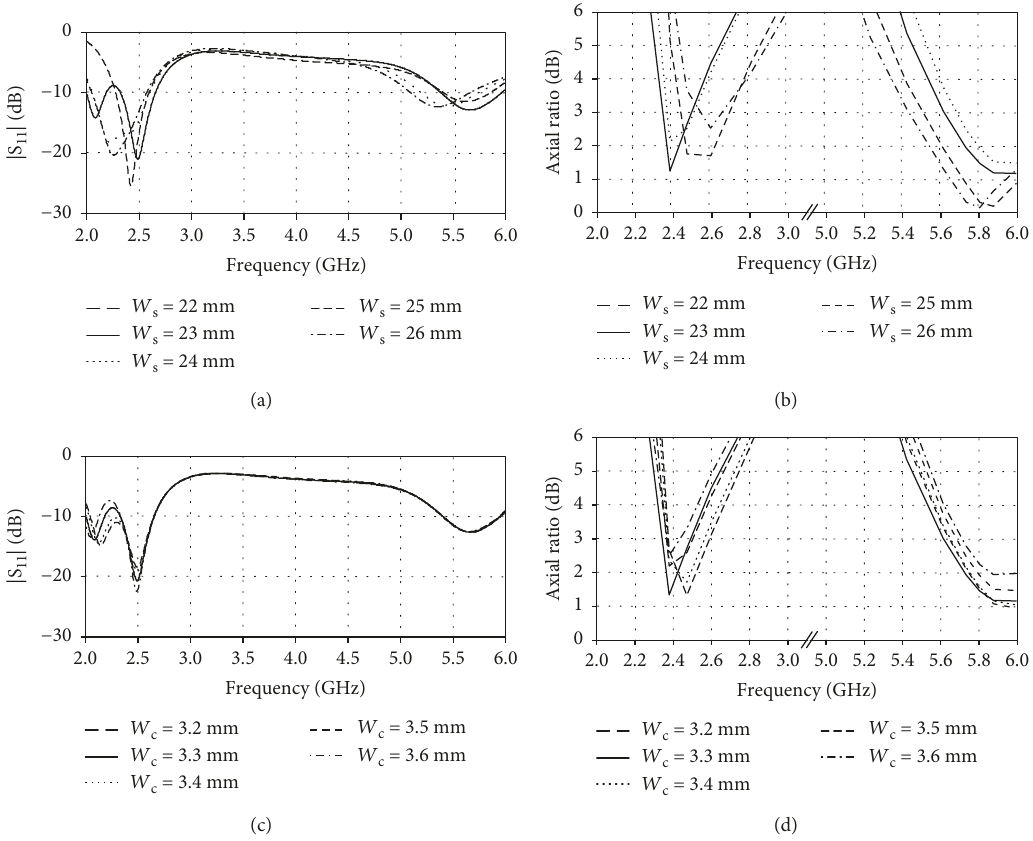
w 11 when s is varied, (b) axial ratio when